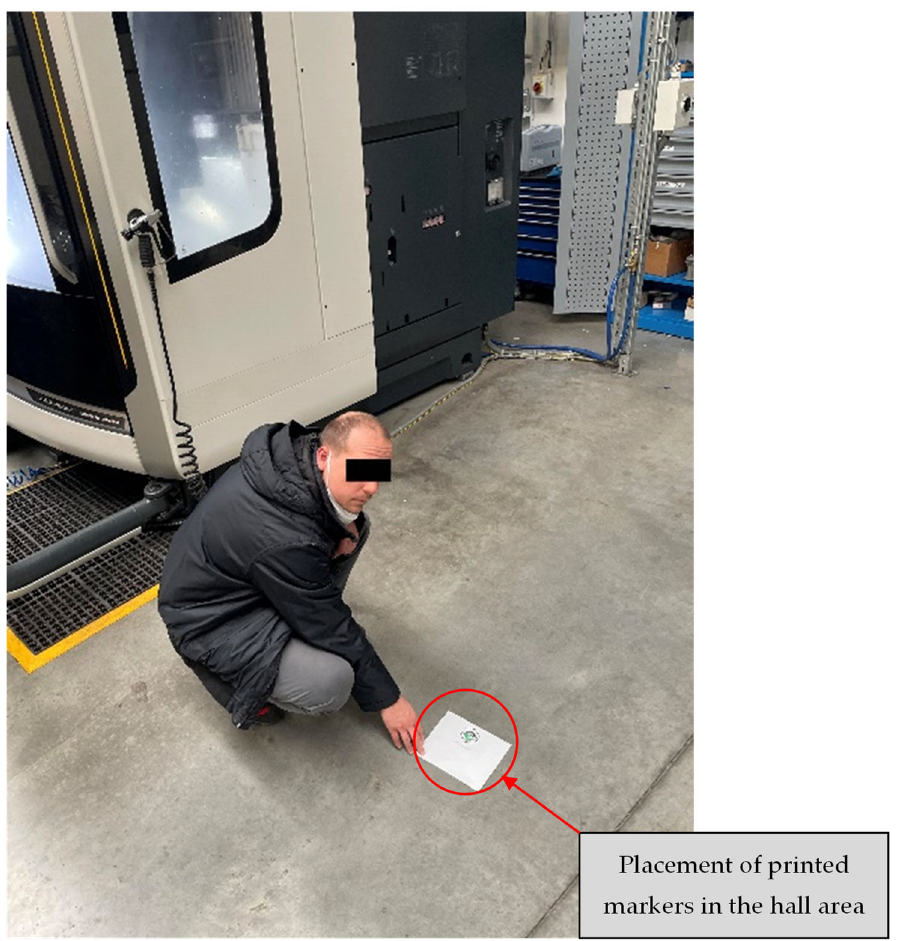
Figure 11. Placement of markers in space.